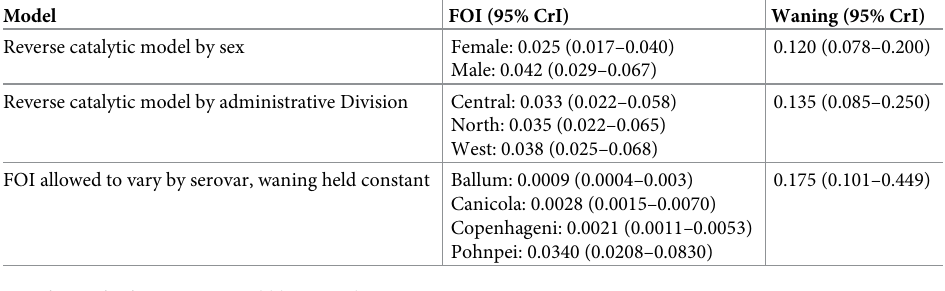
Table 2. Parameter estimates for the FOI and waning for the reverse catalytic model by sex, by administrative division and by serovar (median [95% CrI]).